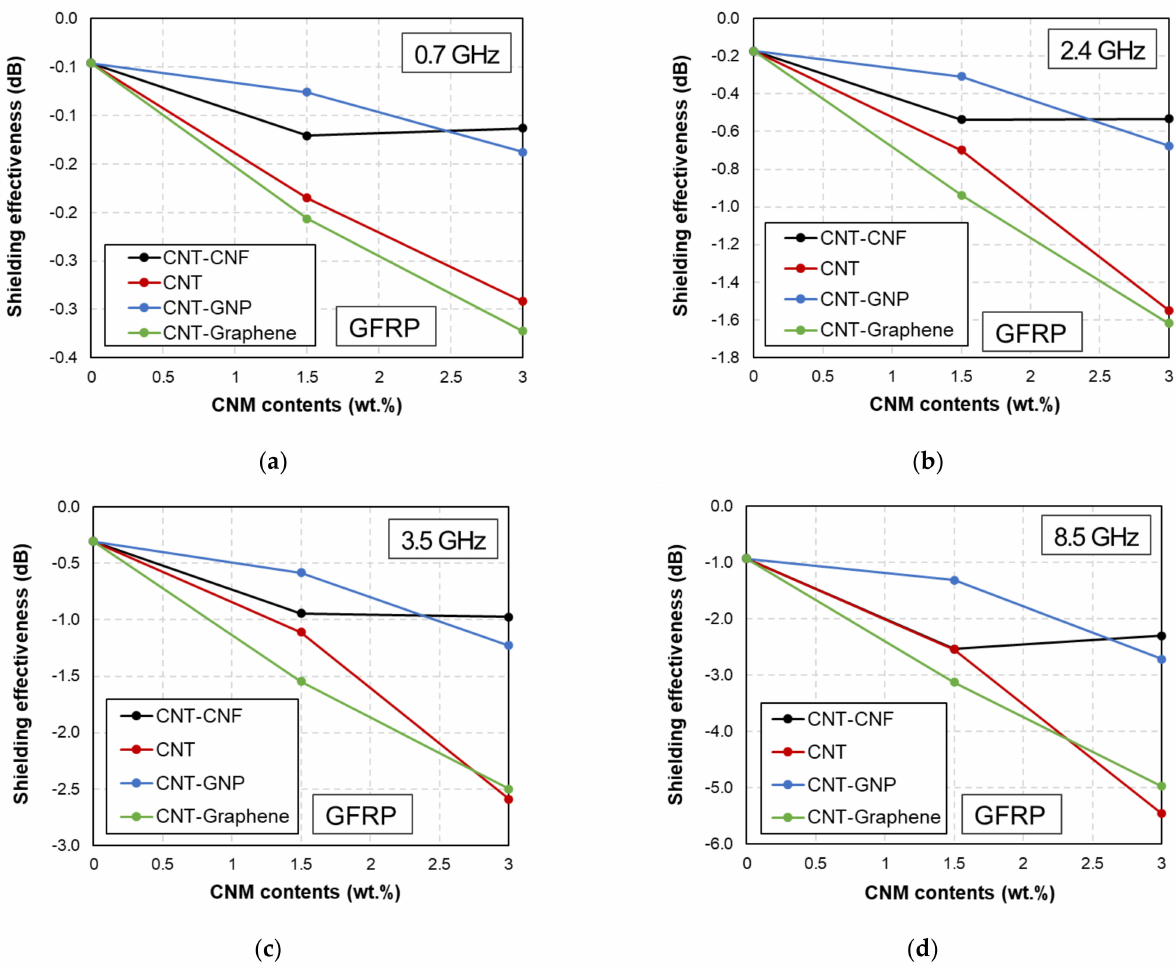
Figure 5. EMI shielding effectiveness of GFRP-based samples with different amounts of CNMs at ( a ) 0.7, ( b ) 2.4, ( c ) 3.5, and ( d ) 8.5